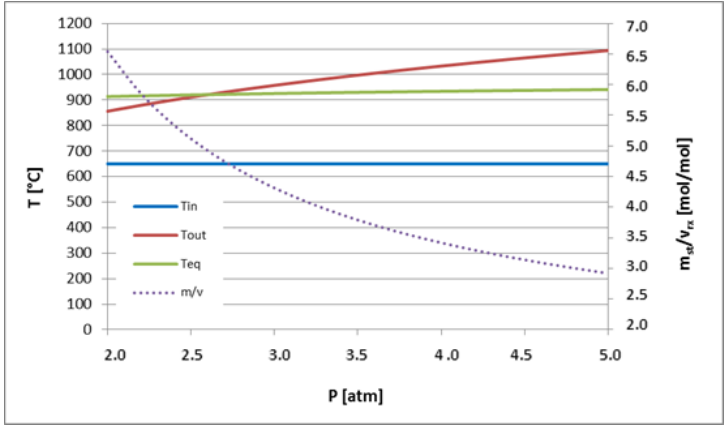
Figure 15. Co 3 O 4– CoO system (charging phase): parametric analysis of the reactor outlet temperature, reactor inlet flow, and reactor equilibrium temperature varying the inlet flow total pressure.